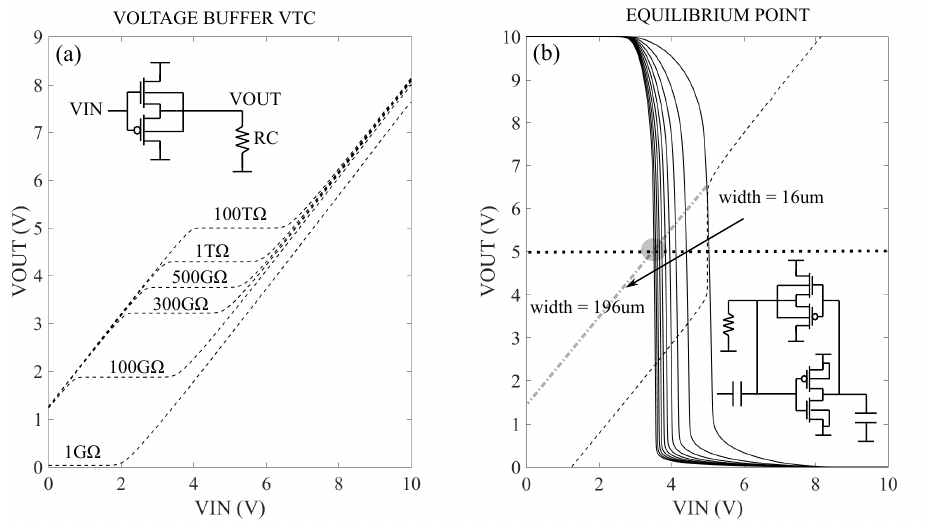
Figure 11. Compensation of the input offset in HV-process CMOS model with V SB = 0 V. ( a ) Voltage buffer VTC curve for different value of R C . ( b ) Equilibrium point for different width of the NMOS in the inverter and for different R C .